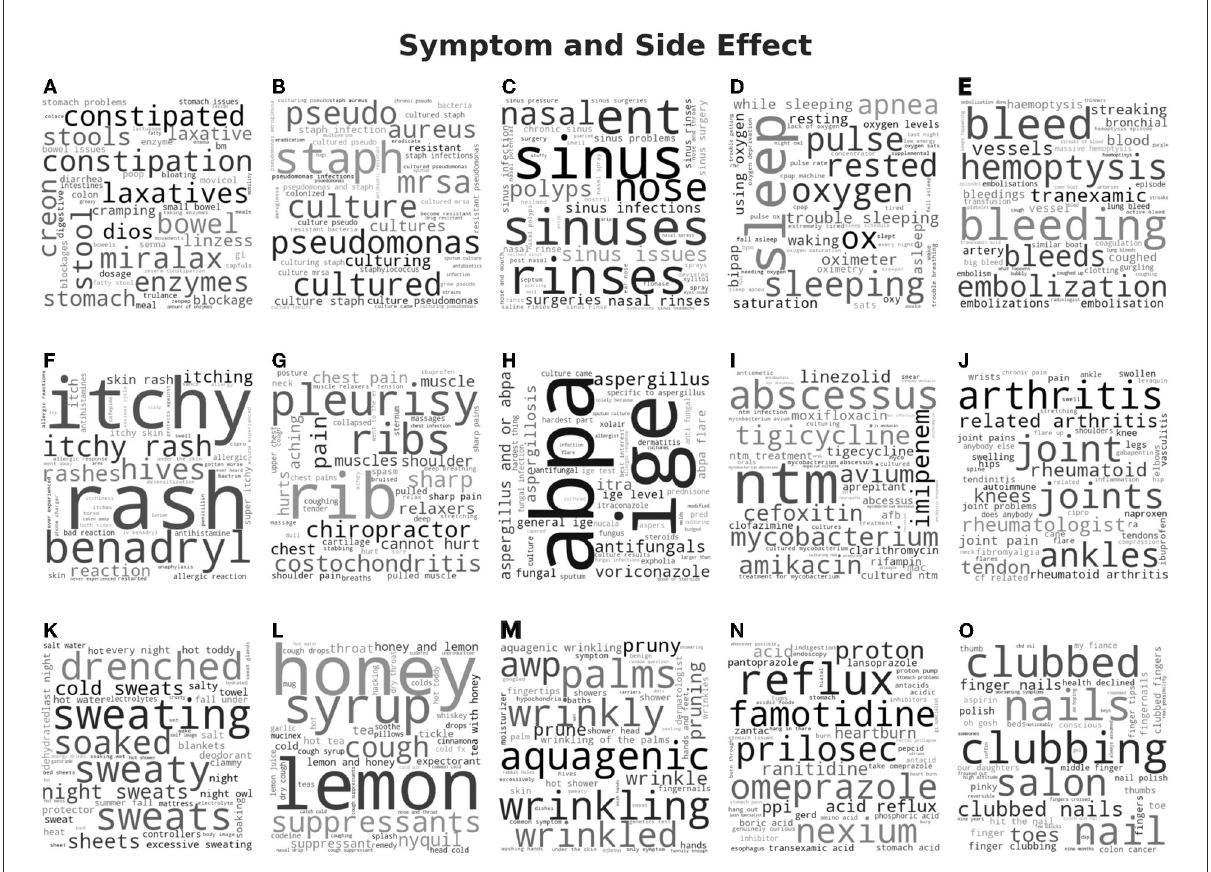
FIGURE6 Word clouds for the topics that were grouped into the symptom and side effect category for the Top2Vec model using doc2vec